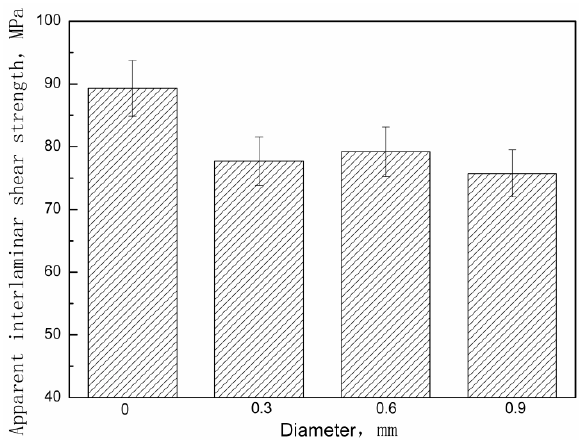
Figure 5. Effect of metal pin diameter on apparent interlaminar shear strength of z-pinned Cf/Al composites using stainless steel pins with a volume content of 1%. Table 4 . Apparent interlaminar shear strength of unpinned Cf/Al composites and z-pinned Cf/Al composites using stainless steel pins with a volume fraction of 1% measured/determined by short-beam shear test.